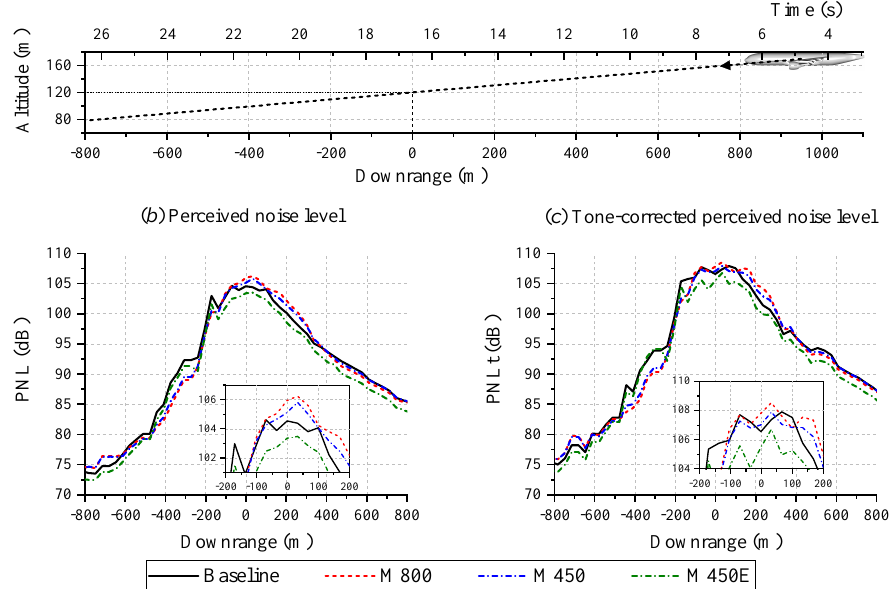
Figure 20. ( a ) The aircraft trajectory for noise footprint analysis, ( b ) the variation of perceived noise level (PNL), and ( c ) the tone-corrected PNL (PNLt) for a reference aircraft approach scenario. The reference microphone is located at the origin of the downrange axis, where the aircraft altitude is